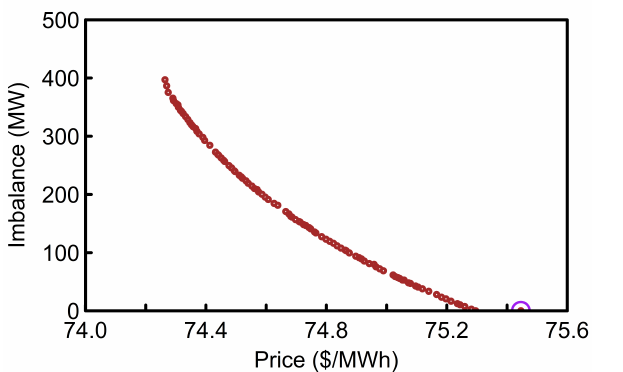
Figure 5. The multi-objective optimization Pareto front for example minute. The selected design is the one with the minimum imbalance for every